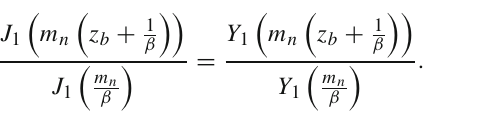
For the light modes ( m n /β (cid:13) 1), the solution (91) in the long-range limit α n ≈